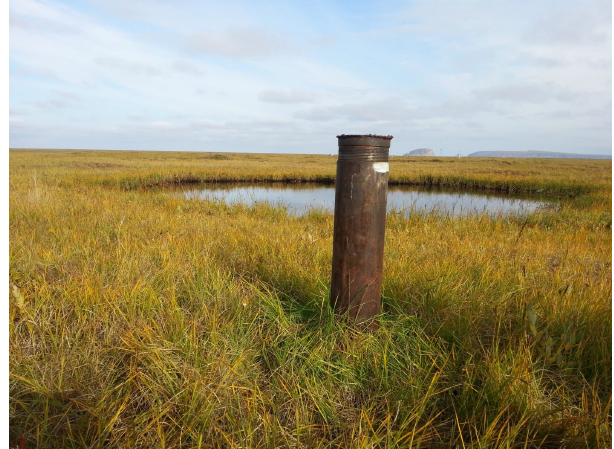
Figure E1. Location of the 2006 borehole showing the proximity of the borehole to a small lake. The metal pipe extends 0.5m above the ground surface.